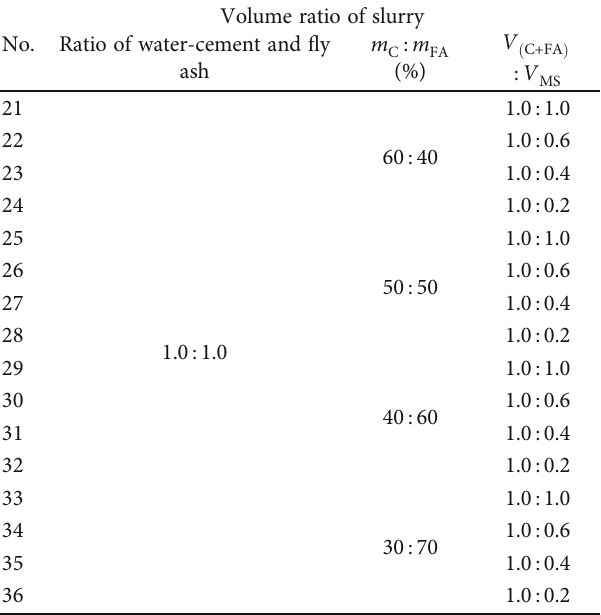
Table 6: Volume ratio of cement- fl y ash-MS slurry (C-FA-MS).